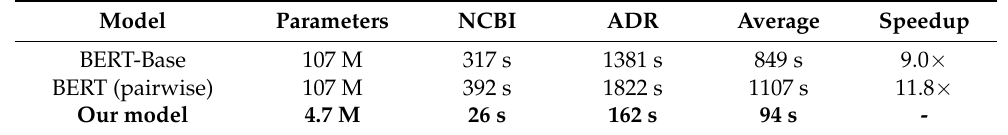
Table 7. Comparison of parameter size and inference time with BERT-base model.